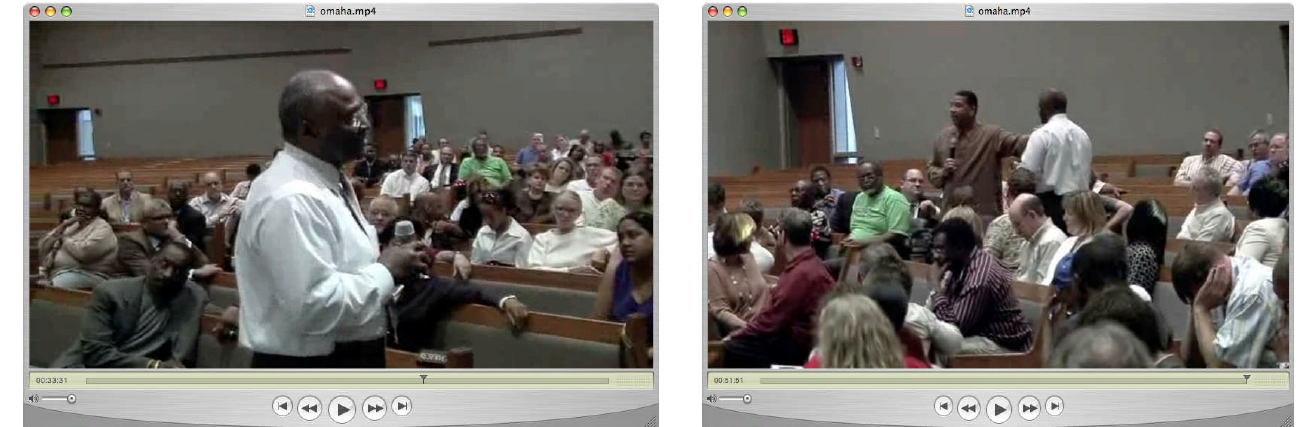
Figure 6: Dick Davis actively displaying alignment